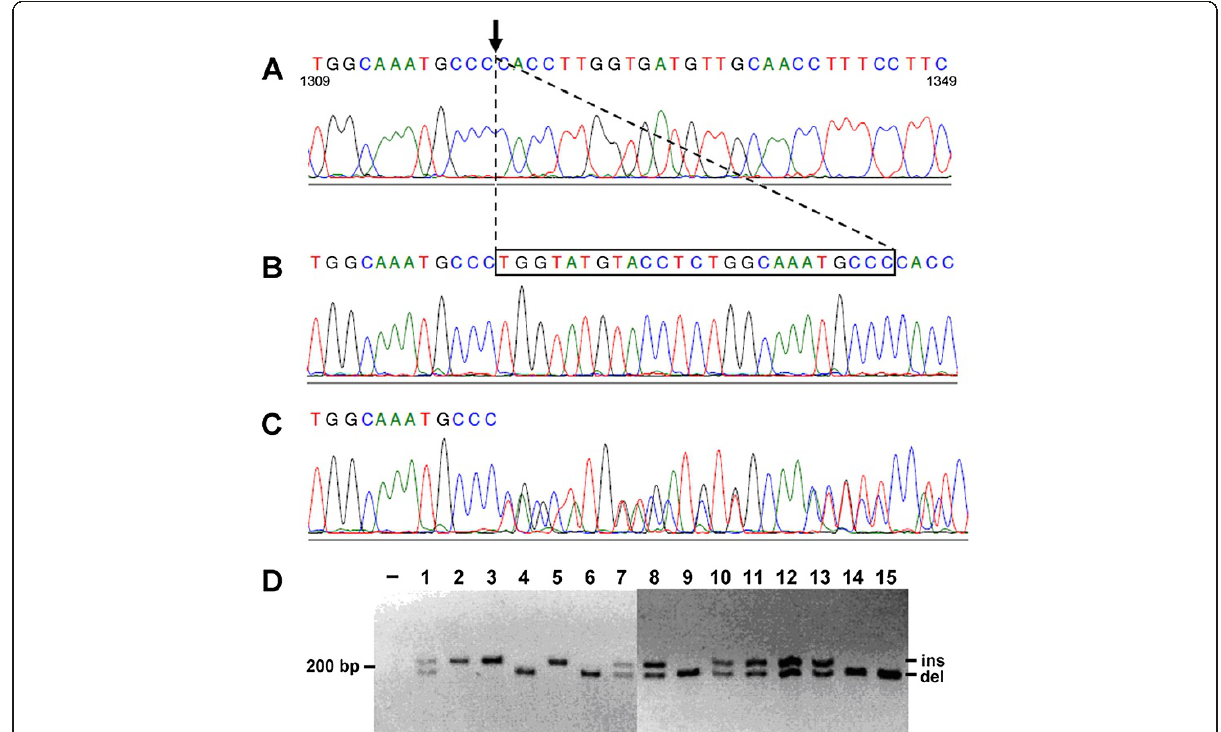
Figure 2 Identification of a 25 bp insertion/deletion polymorphism in the GJA5 3 0 UTR. Sequence traces from human atrial gDNA from ( A ) a deletion homozygote, ( B ) an insertion homozygote, and ( C ) a heterozygote are shown. Nucleotide sequence numbering is based on the GJA5 Refseq entry (NM_181703). ( D ) PCR assay of atrial gDNA from 15 individuals, identifying homozygotes for the insertion (upper band, 206 bp), homozygotes for the deletion (lower band, 181 bp), and heterozygotes (with both bands). Screening of 67 atrial samples determined the minor allele frequency of the insertion to be